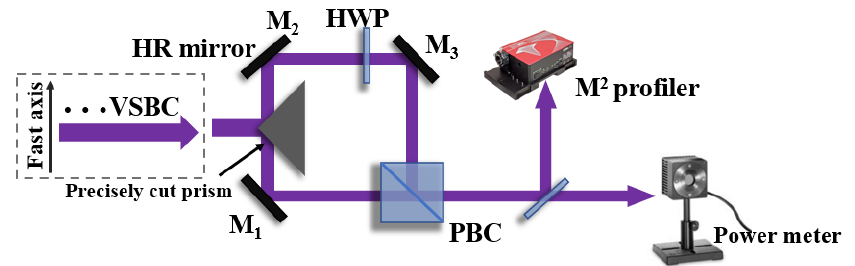
Figure 2. Schematic diagram of BSPC setup.